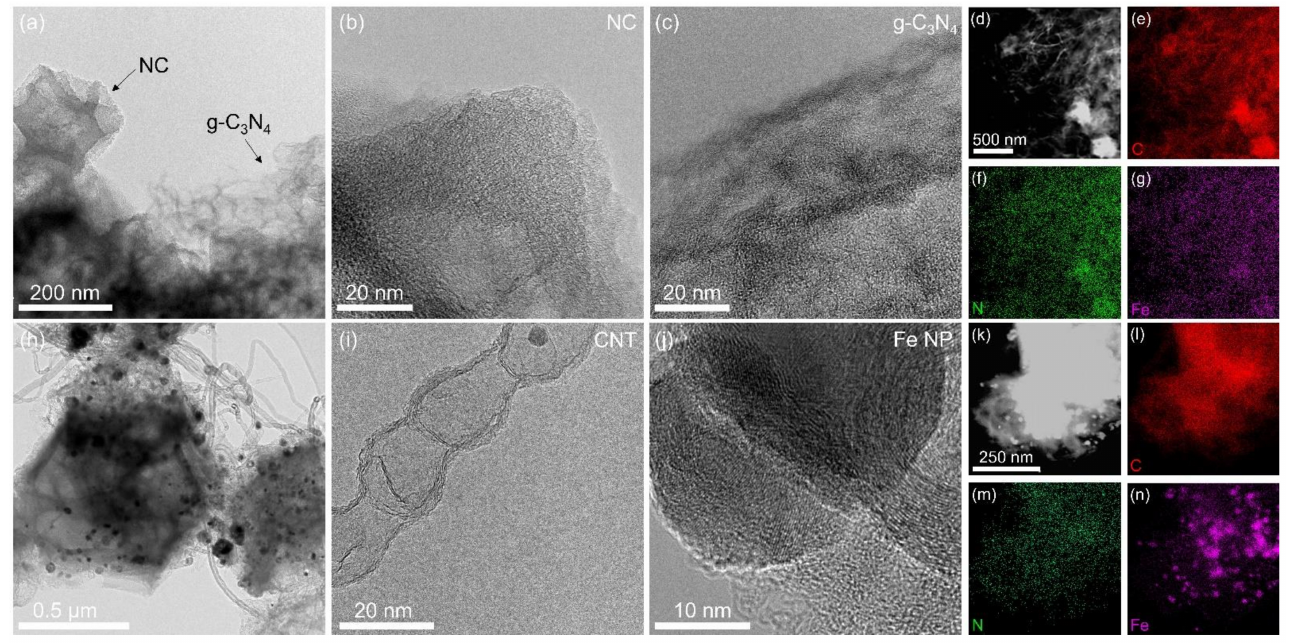
Figure 2. TEM image of ( a ) Fe-C 3 N 4 -0.075; ( b ) HRTEM image of NC and ( c ) HRTEM image of g-C 3 N 4